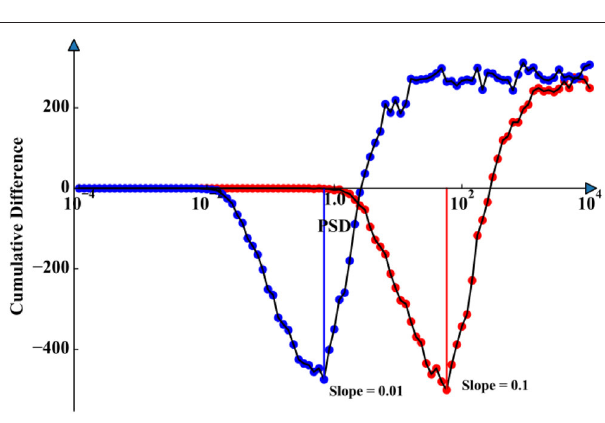
0.01 and (B) slope value 0.1. = =